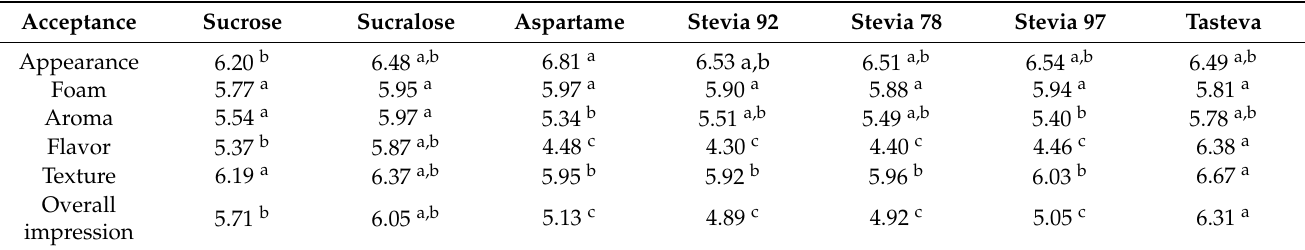
Table 5. Means * of acceptance in relation to appearance, foam, aroma, flavor, texture, and overall impression of blackberry nectar to the blackberry nectar in the equi-sweet ideal